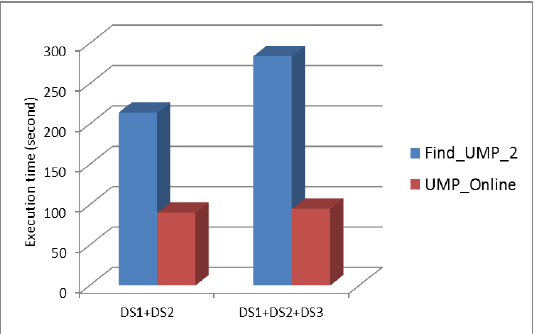
Figure 5 . The execution time of two